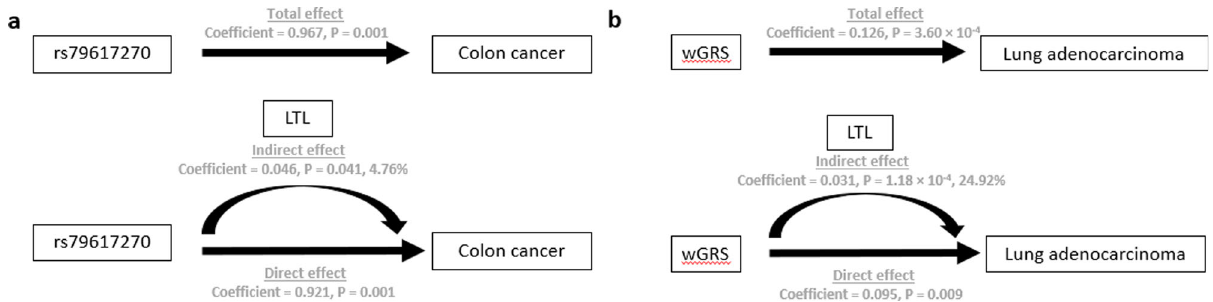
Fig. 2 Mediation analysis to quantify how much the genetic variant affects incident cancer through LTL. a Proportion of rs79617270 total effects on colon cancer mediated through LTL = 4.76. b Proportion of wGRS total effects on lung adenocarcinoma mediated through LTL = 24.92%. Table 4 Association of weighted genetic risk score for increased LTL with major incident cancers in the SCHS dataset.